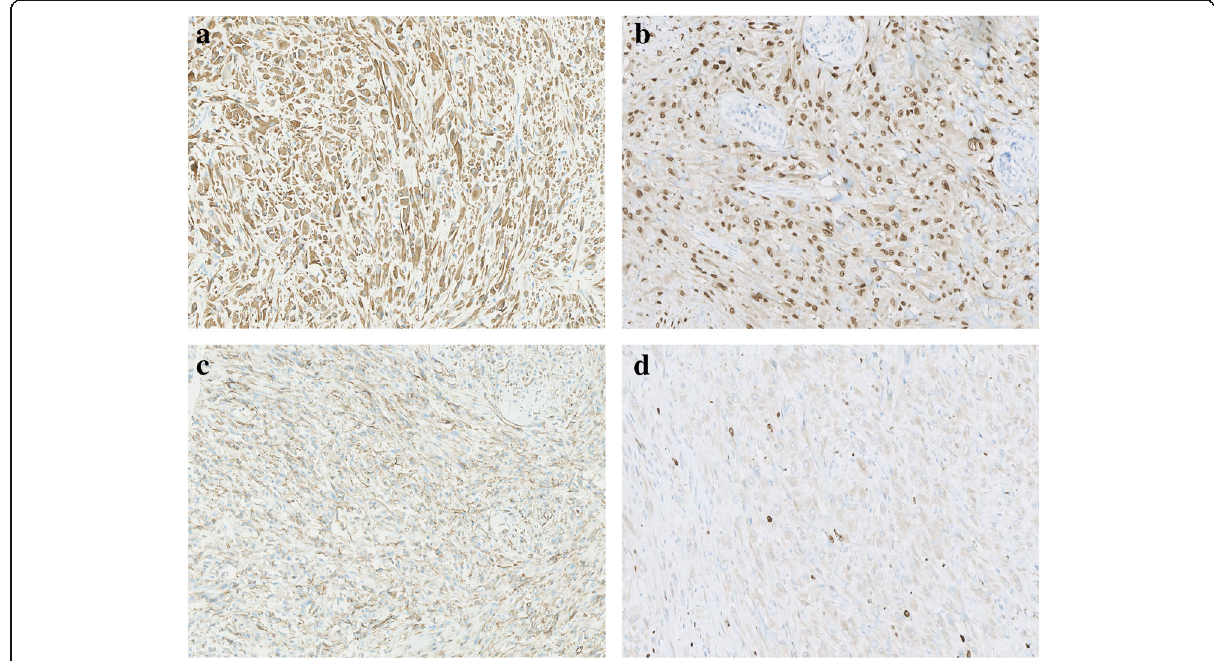
Fig. 2 Tumor cells showed diffuse staining of AE1/AE3 ( a ) and ERG ( b ) with partial expression of CD31 ( c ). The Ki67 index was relatively low ( d ).